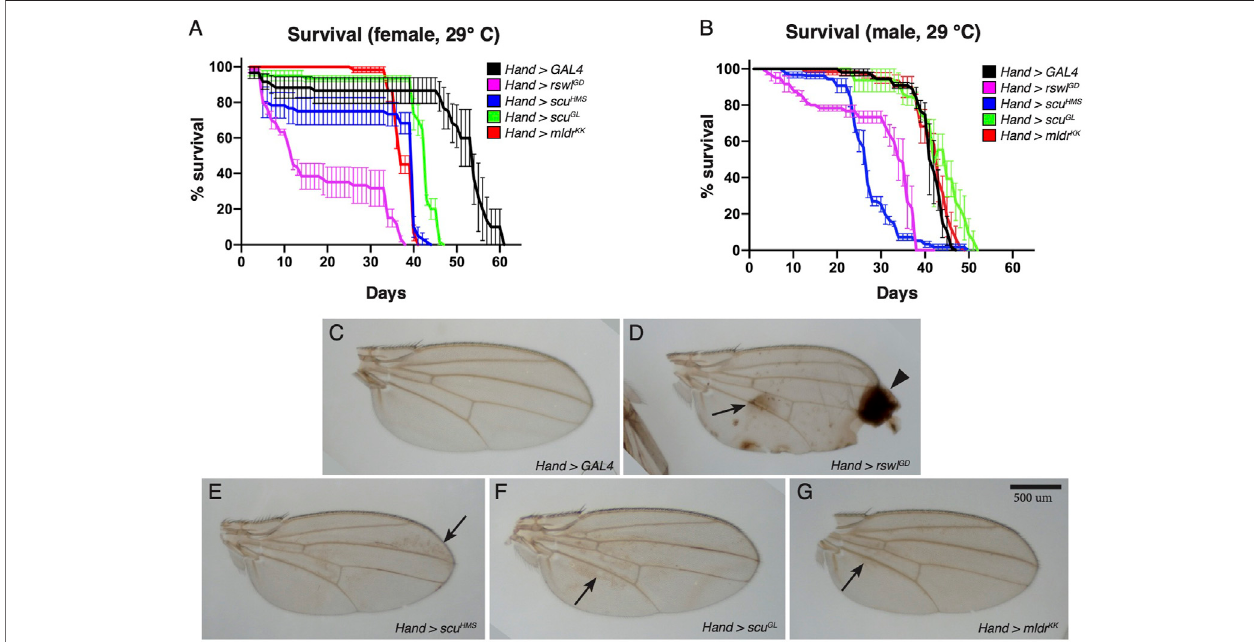
FIGURE 4 | Reduction of mtRNase P subunits in the heart reduces lifespan and causes wing defects. (A,B) Lifespan measurements for adults grown at 29 ° C expressing mtRNase P RNAiusing Hand GAL4. Forfemales (A) , allRNAi genotypes have statistically shortenedlifespans compared to GAL4 RNAi control(Bonferroni p value=0).Formales (B) , rswl GD RNAi(Bonferroni p value=0)and scu HMS RNAi(Bonferroni p =0)havestatisticallyshortenedlifespanscomparedto GAL4 RNAicontrol. (C – G) Representative wings from Hand > GAL4 , rswl GD , scu HMS , scu GL , and mldr KK female fl ies grown at 29 ° C. mtRNase P RNAi wings have brown discoloration [ (D – G) ,arrows]comparedto GAL4 RNAi control (C) . Hand > rswl GD RNAi wingsalso haveblistering andscarring[ (D) ,arrowhead]. (A,B) Errorbars =s.e.m. Thegraphs were plotted using GraphPad Prism. The signi fi cance between the survival distributions was done using the Log-Rank test between the combined triplicates using OASIS 2. More details can be found in the materials and methods. Scale bar = 500 μ m in G for (C – G)